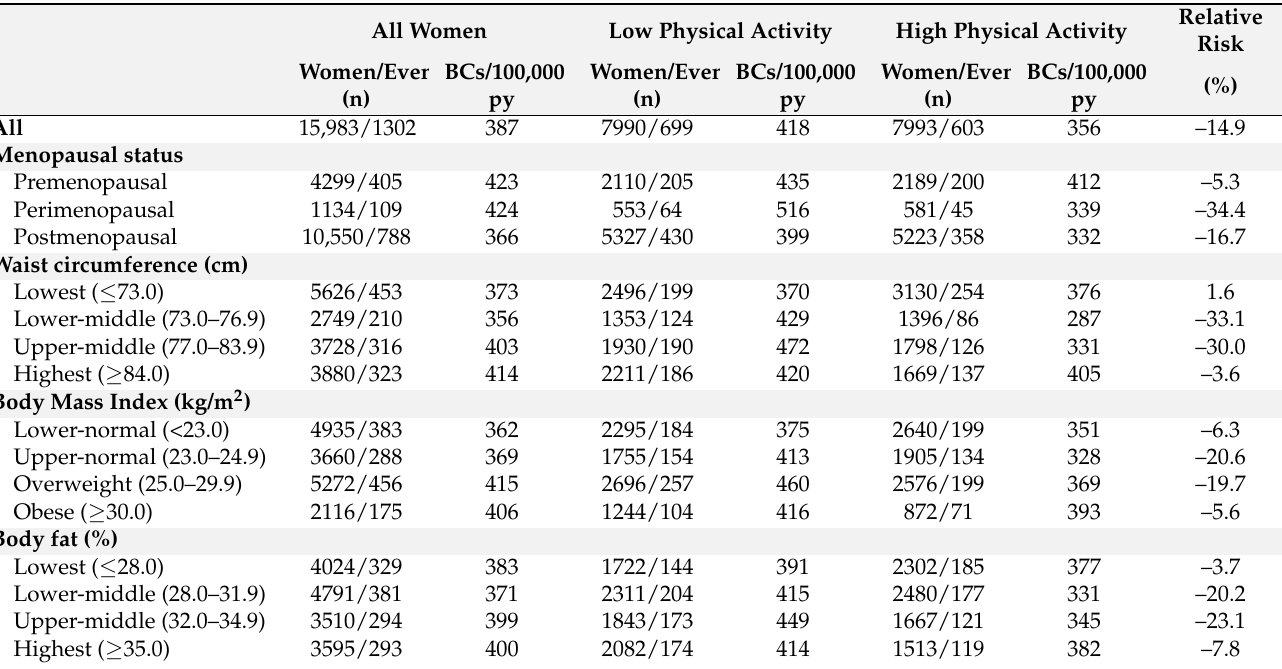
Table 3. Breast cancer incidence per 100,000 person-years (py) for all women, and according to physical activity